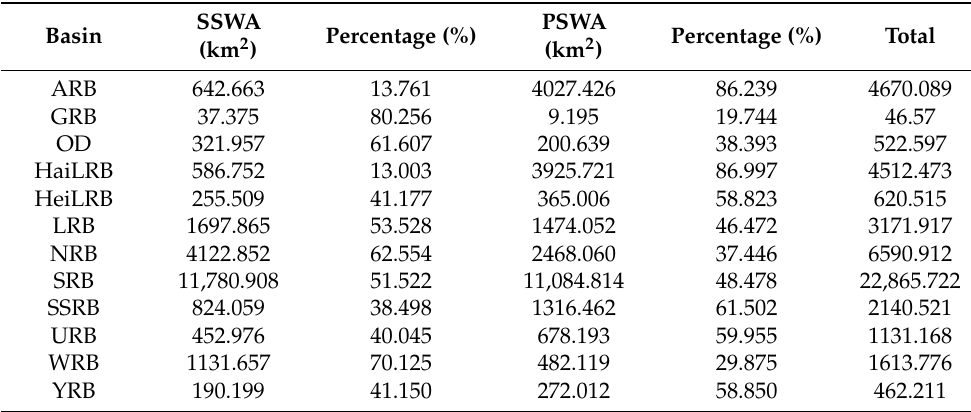
Figure 4. ( a ) The spatial distribution of surface water bodies and the proportion of SSWA and PSWA in Northeast China in 2020; ( b – g ) are Nierji Reservoir, Chagan Lake, Hulun Lake, Ulagai Lake, Chagannuoer, and Fengman Reservoir, respectively. Table 1. Mean SWA values of watersheds for 1988–2020.